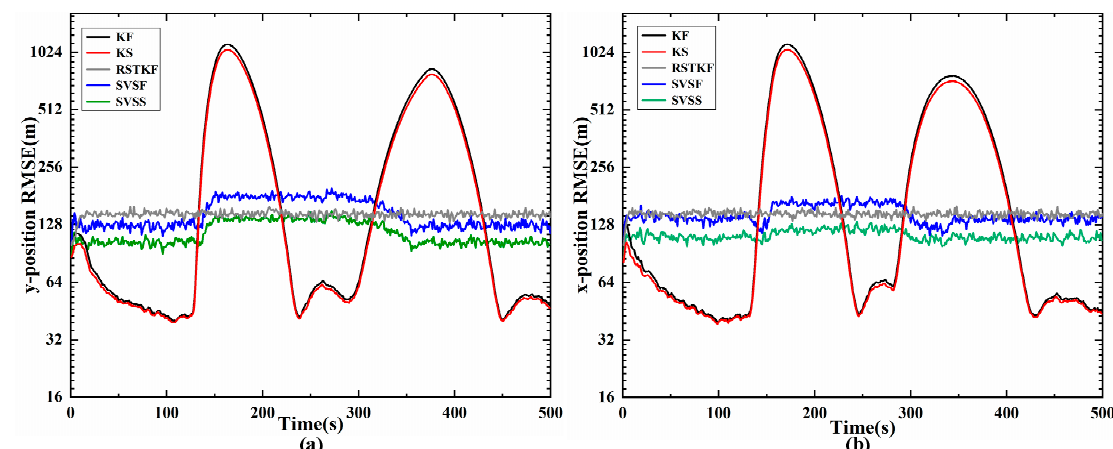
Figure 5. Position of RMSE of x-axis and y-axis (m) (a) position of RMSE on x-axis; (b) position of RMSE on y-axis. Table 1. The position accumulative RMSE on the x-axis and y-axis (m).